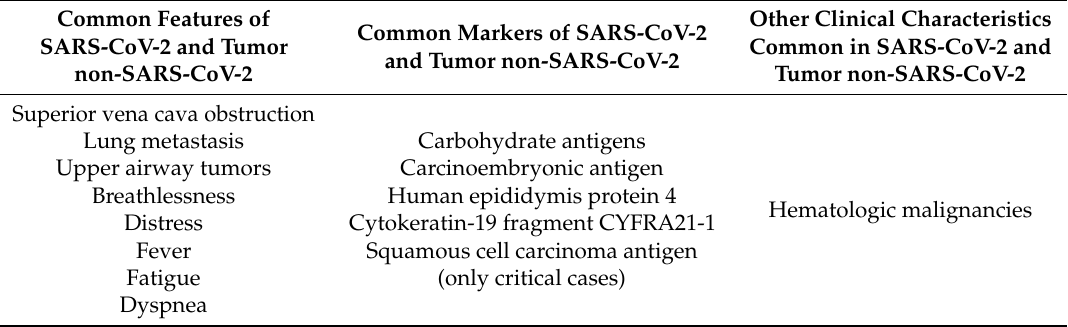
Table 2. Common features, markers and clinical characteristics between SARS-CoV-2 and tumor non-SARS-CoV-2.